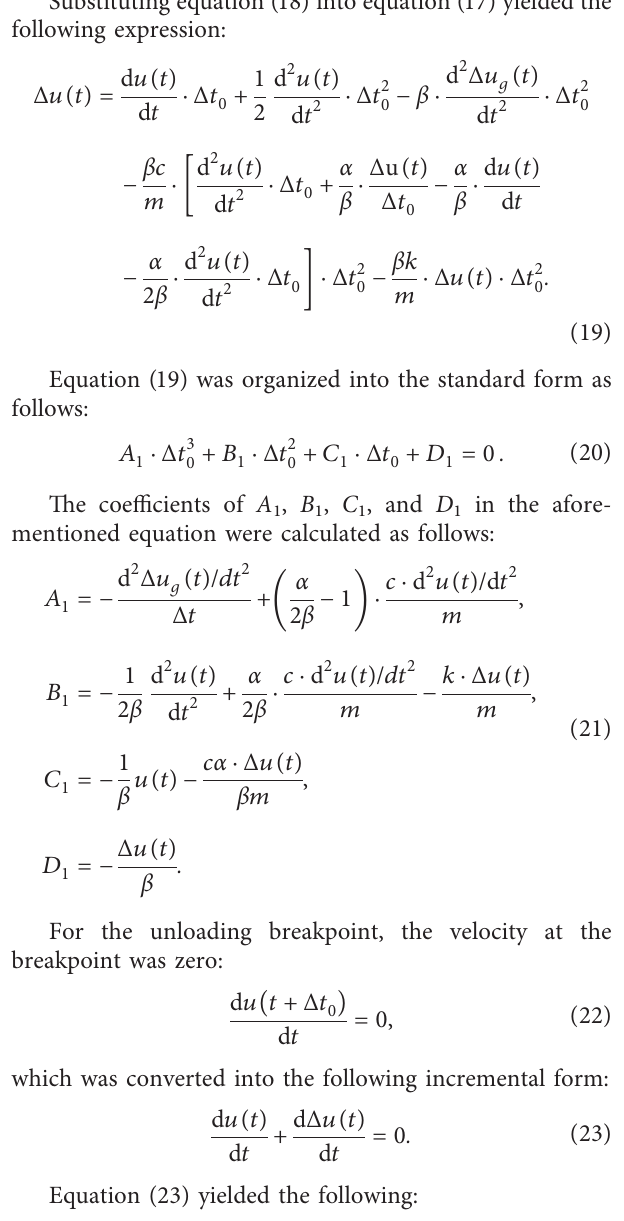
Figure 3: Loading point (first